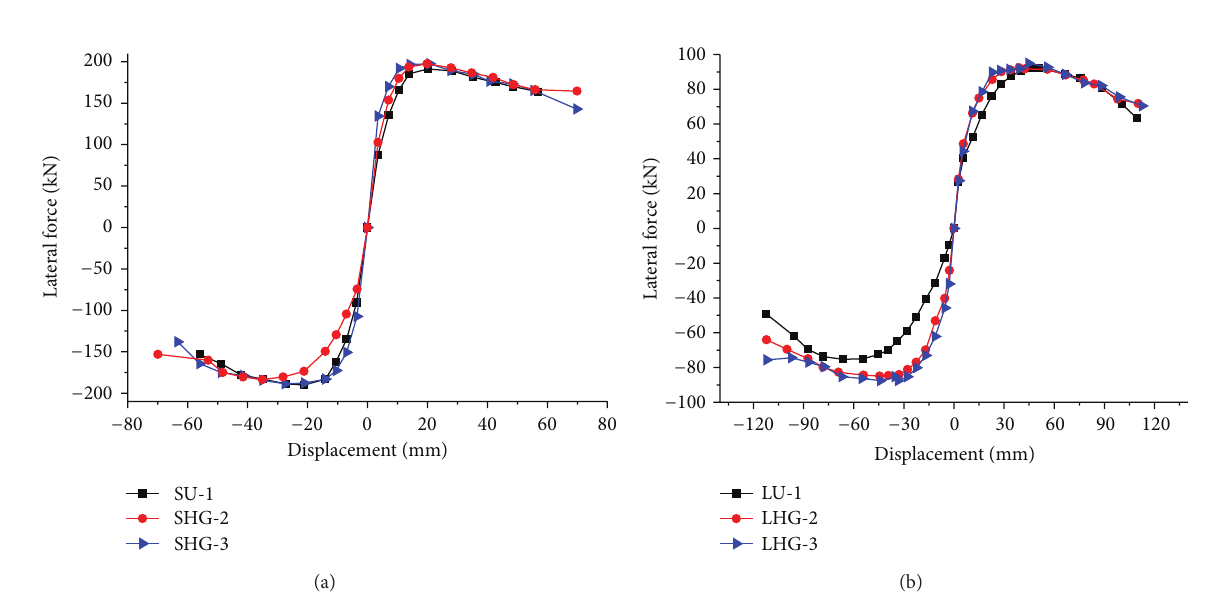
Figure 3: Lateral force-displacement hysteresis loops of specimen.